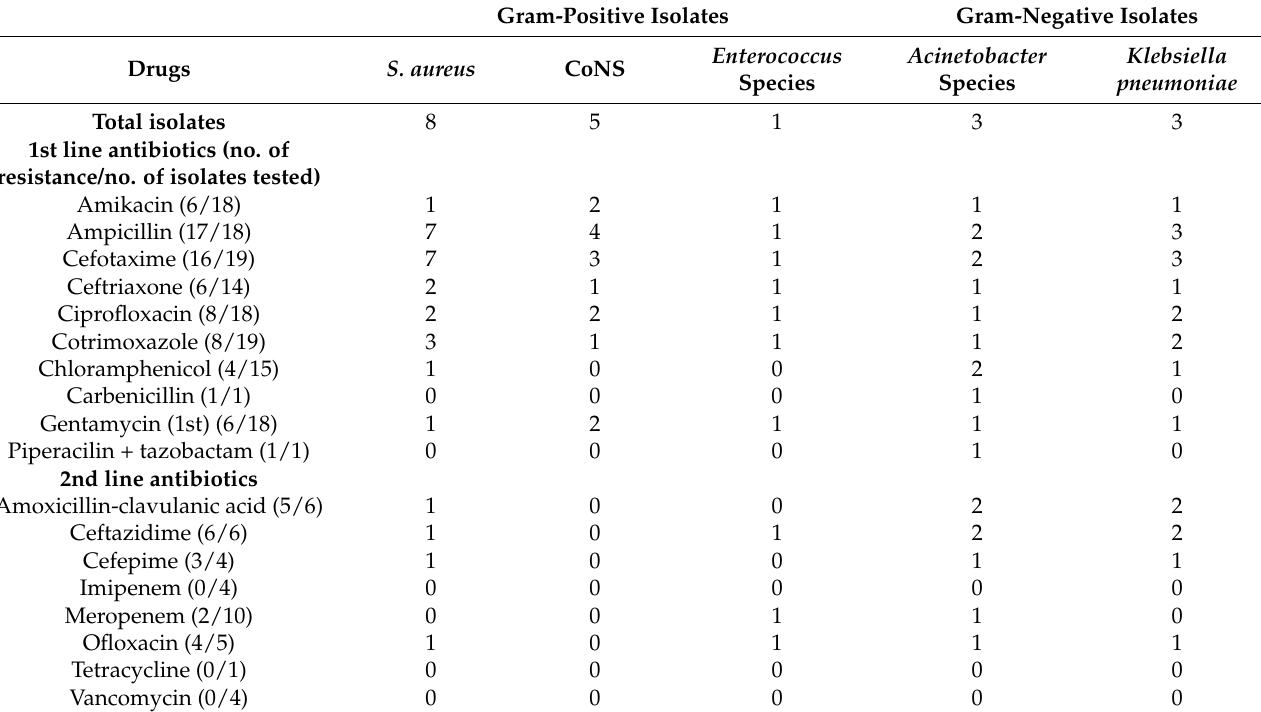
Table 3. Profile and antimicrobial resistance pattern of Gram-positive isolates (N = 14) and Gram-negative isolates (N = 6) among neonates with bacteriologically confirmed sepsis admitted to NICU at KIST MCTH, Kathmandu Valley, Nepal during 2018–2019 (R =